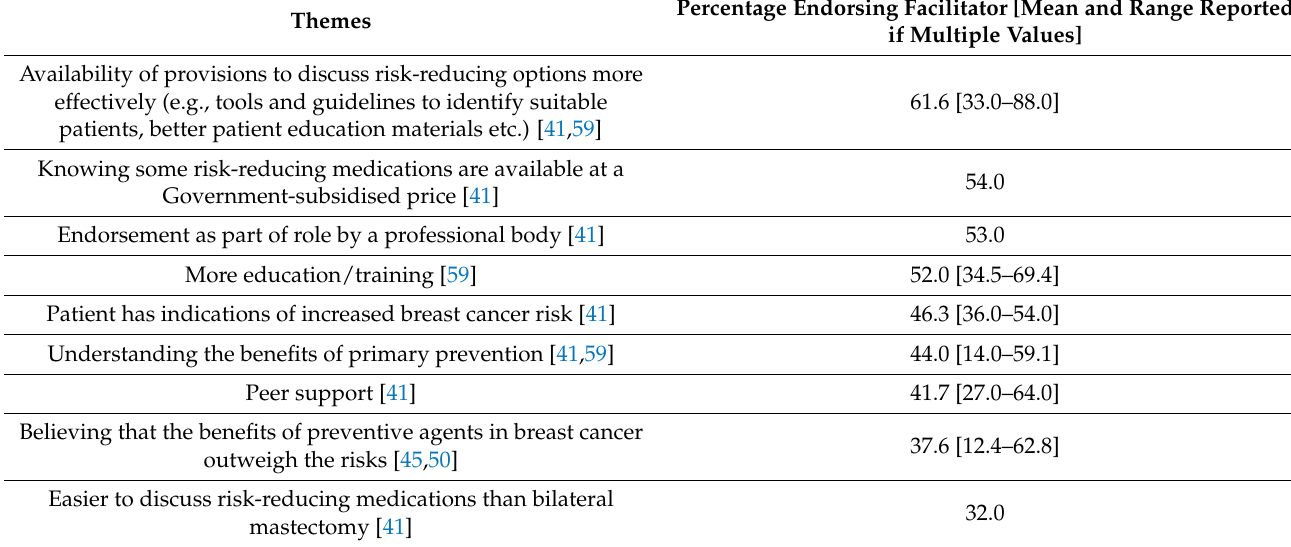
Table 7. Primary care providers’ perceptions of facilitators associated with providing primary prevention